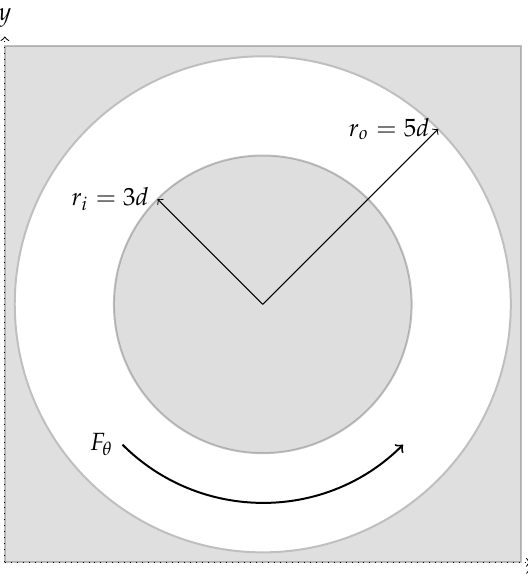
Figure 10. Geometry considered for the case of flow between concentric cylindrical